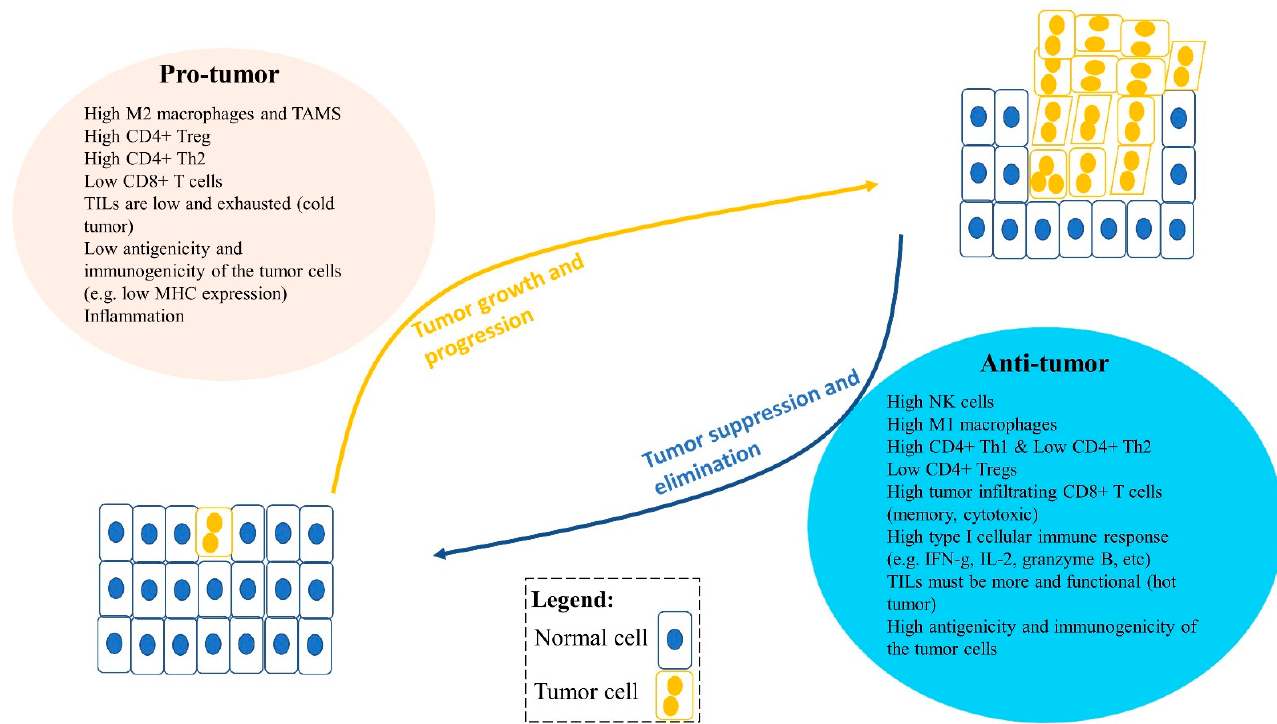
Figure 2. An imbalance between pro-tumor and anti-tumor immune cells and factors in the tumor microenvironment (TME) can lead to tumor growth and progression or tumor suppression and elimination. Pro-tumor immune cells can promote tumor progression, including type II M2 or TAMs (tumor-associated macrophages), regulatory T cells (Tregs), and type II Th2 cells. Moreover, factors that influence tumor progression are low tumor infiltrating lymphocytes (TILs) in the TME, low antigenicity and immunogenicity of tumor cells, and inflammation. Anti-tumor immune cells can reduce tumor growth and suppress tumor progression in the TME. These include CD8+ T cells, type I Th1 cells, NK cells, and type I M1 cells and their type I cytokines such as IFN γ , TNF α , IL-2, and granzyme B. Furthermore, anti-tumor immune factors can also influence tumor suppression, including high infiltration of functional TILs, and greater antigenicity and immunogenicity of the tumor cells, such as high MHC-I expression and tumor-associated antigen expression.